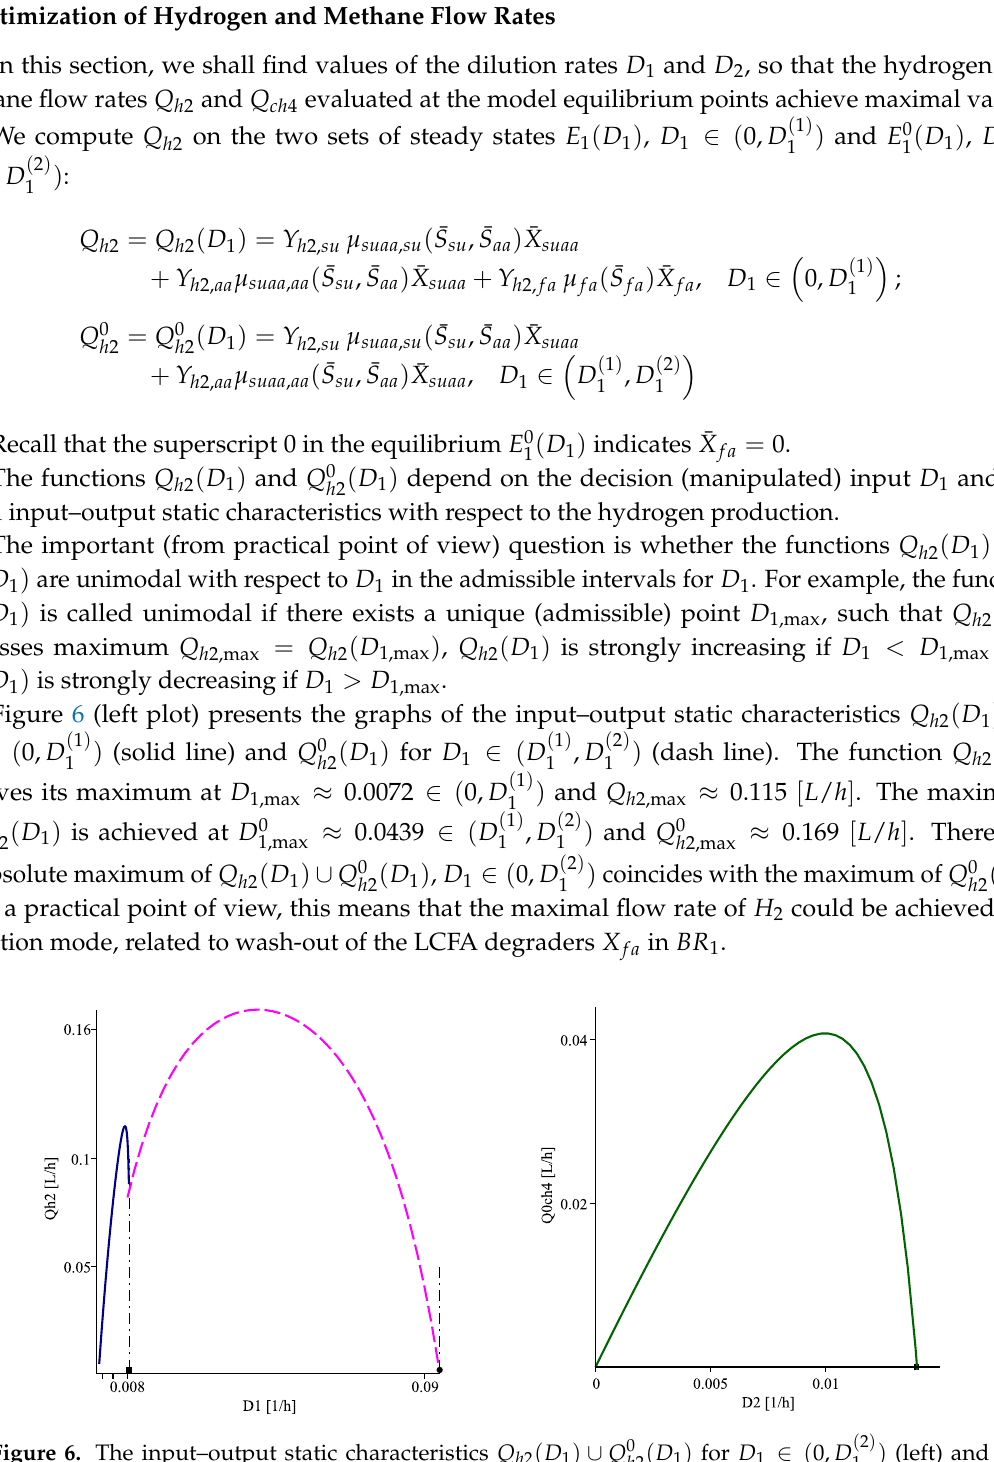
( D ) for D ∈ ( 0, D ( 2 ) ) (left) and 1 1 1 h 2 ( 1 ) is marked by a sold 2